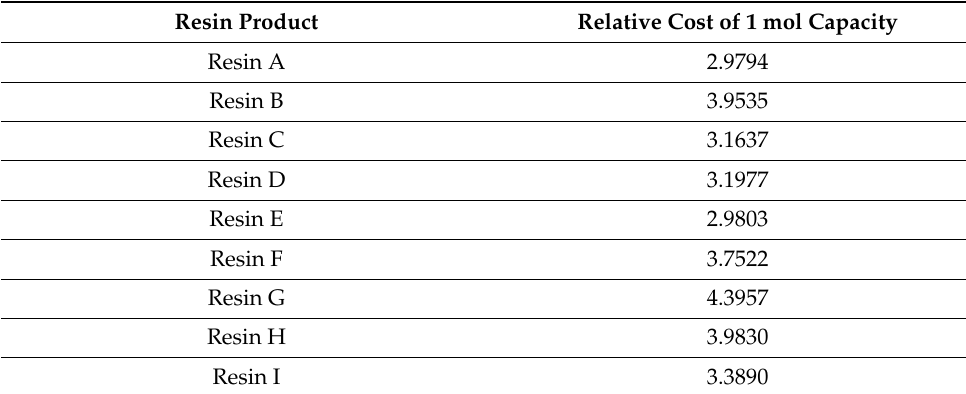
Table 3. The relative cost of 1 mol capacity for resin products.